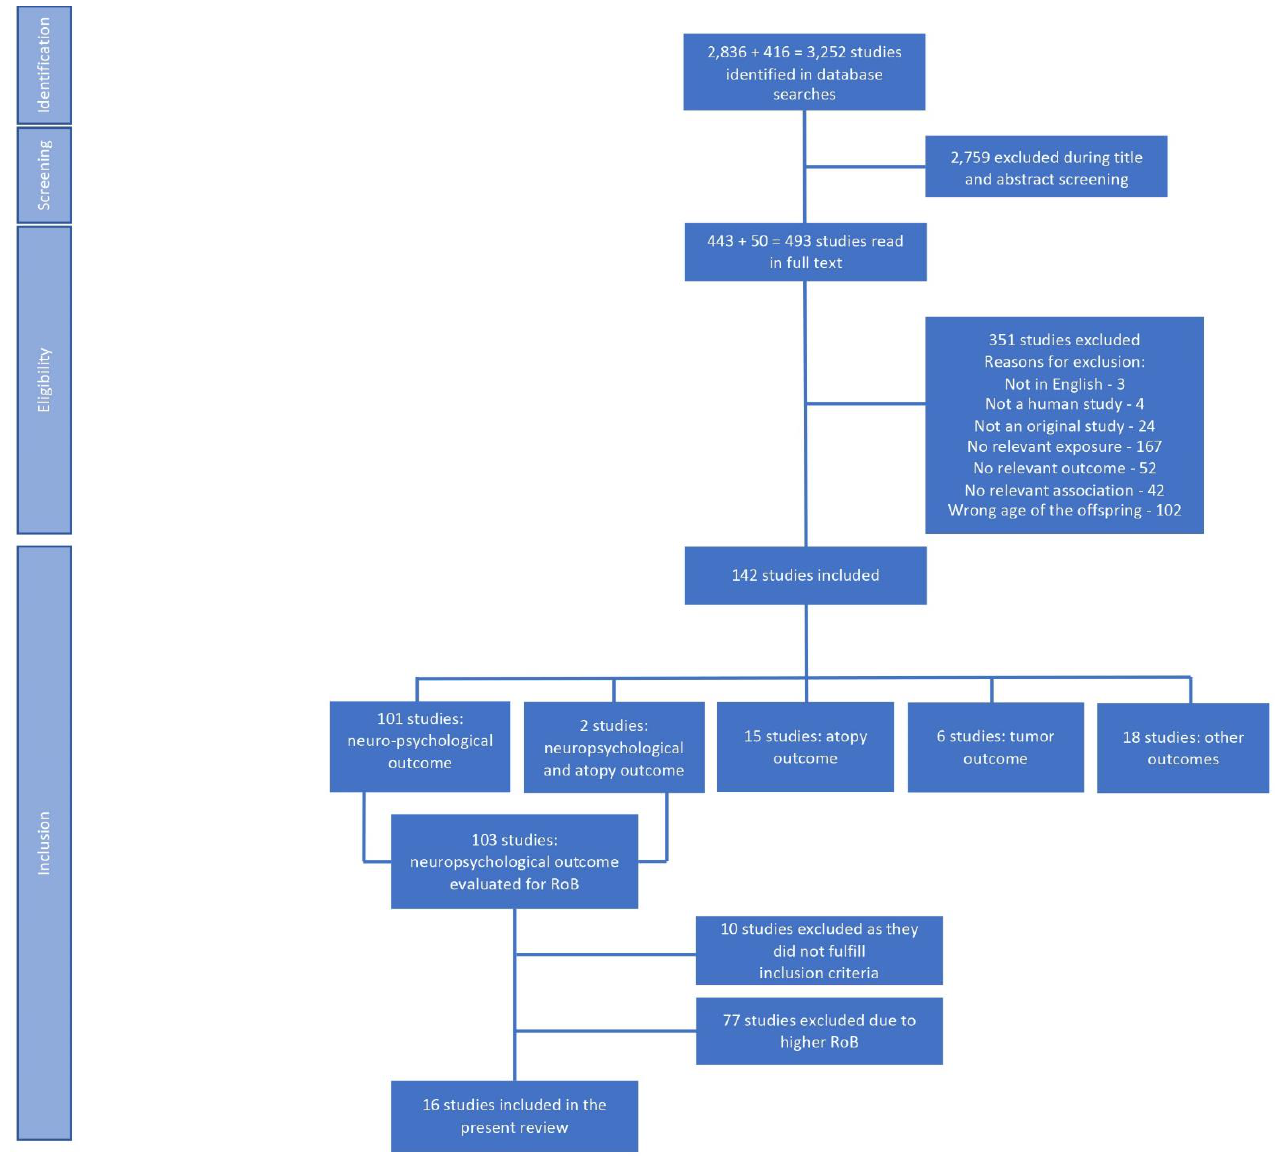
Figure 1. Flowchart of the process from identification to inclusion of the studies in the